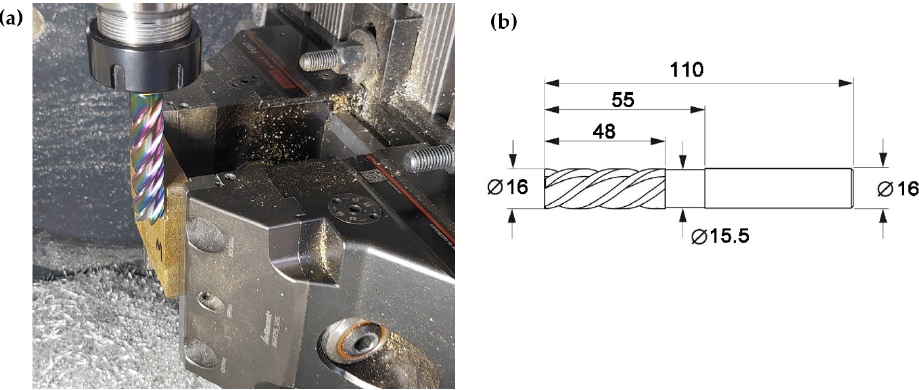
Figure 4. Composite processing, ( a ) sample mounting, ( b ) parameters of the tool used in the process . Tool shank according to DIN 6535 HA with h5 tolerance. A tool holder was used, made in accordance with ISO 7388-1, type ER32 SK40 A100, maintaining a rotational accuracy of ≤ 3 µm and balancing accuracy of G 2.5 at a rotational speed of 25,000 min − 1 .